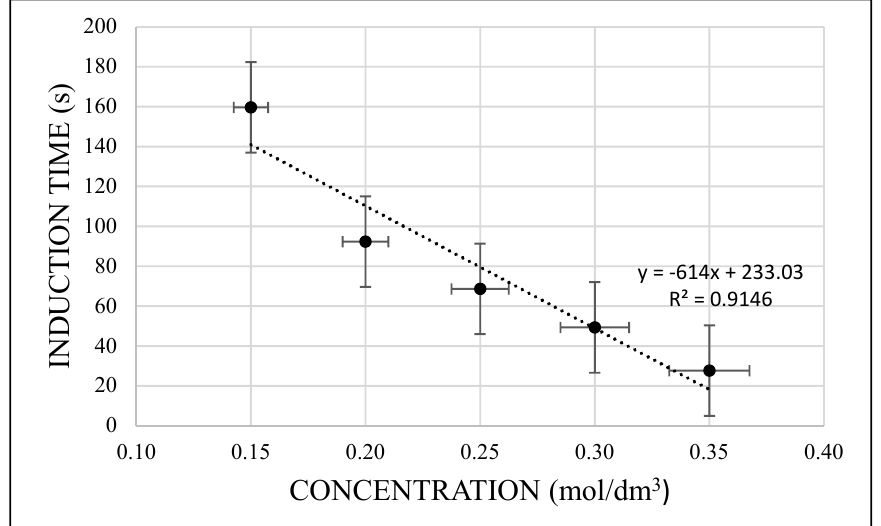
Figure 2. Induction time as a function of concentration.